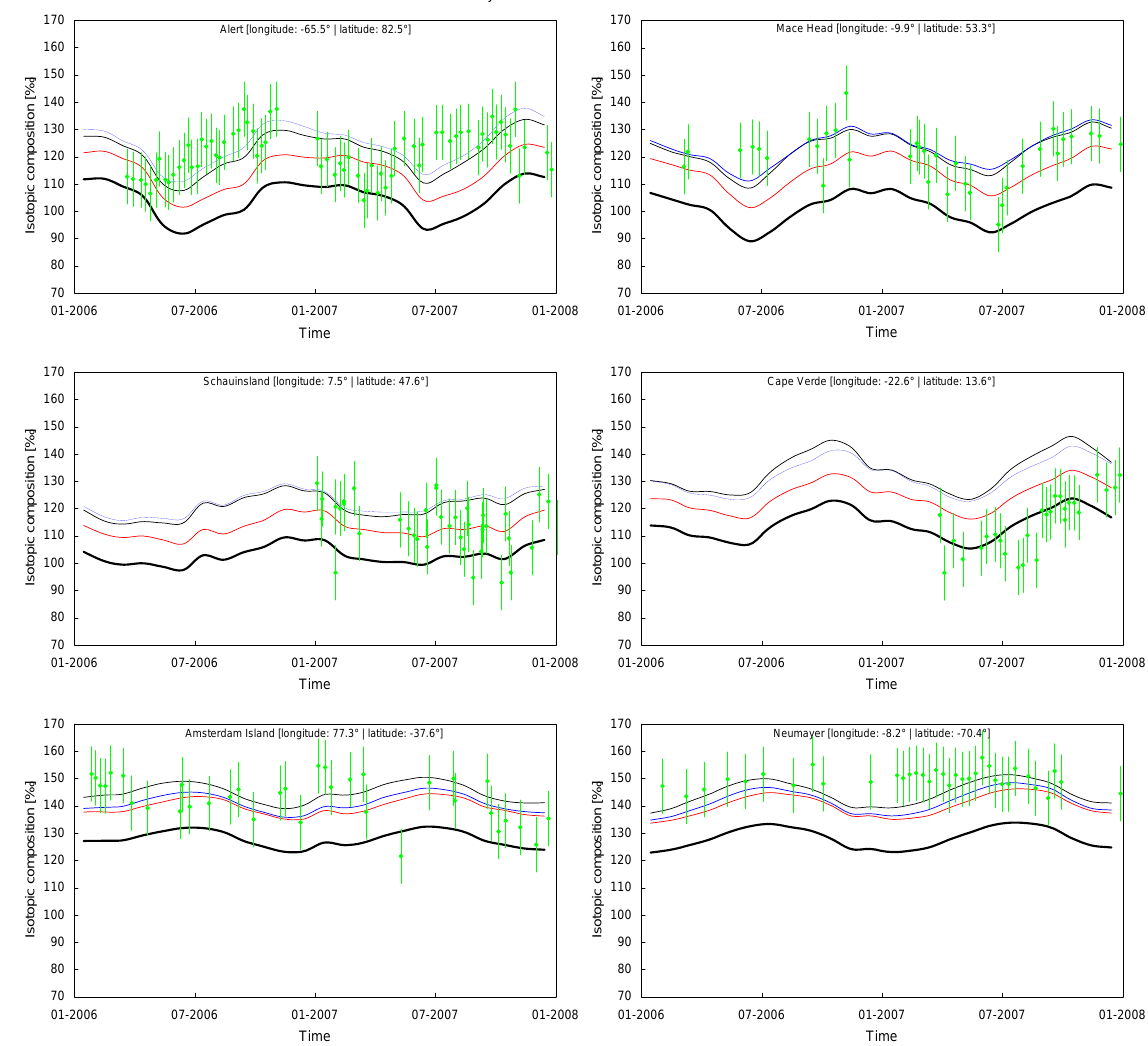
Fig. 4. Comparison of the modelled isotopic composition (thick black) with available measurements (green) from Alert, Mace Head, Schauinsland, Cape Verde, Amsterdam Island, and Neumayer. The corresponding H 2 mixing ratios can be found in Batenburg et al. (2011). Also shown are some of the cases of the sensitivity study discussed in Sect. 3.6. case 1b (thin black) shows the effect of changing the pressure dependency of the molecular channel of formaldehyde removal by photolysis, case 2a (red) the effect of increasing the stratospheric isotopic composition by 20‰, and case 5 (blue) the effect of changing the deposition fractionation constant to